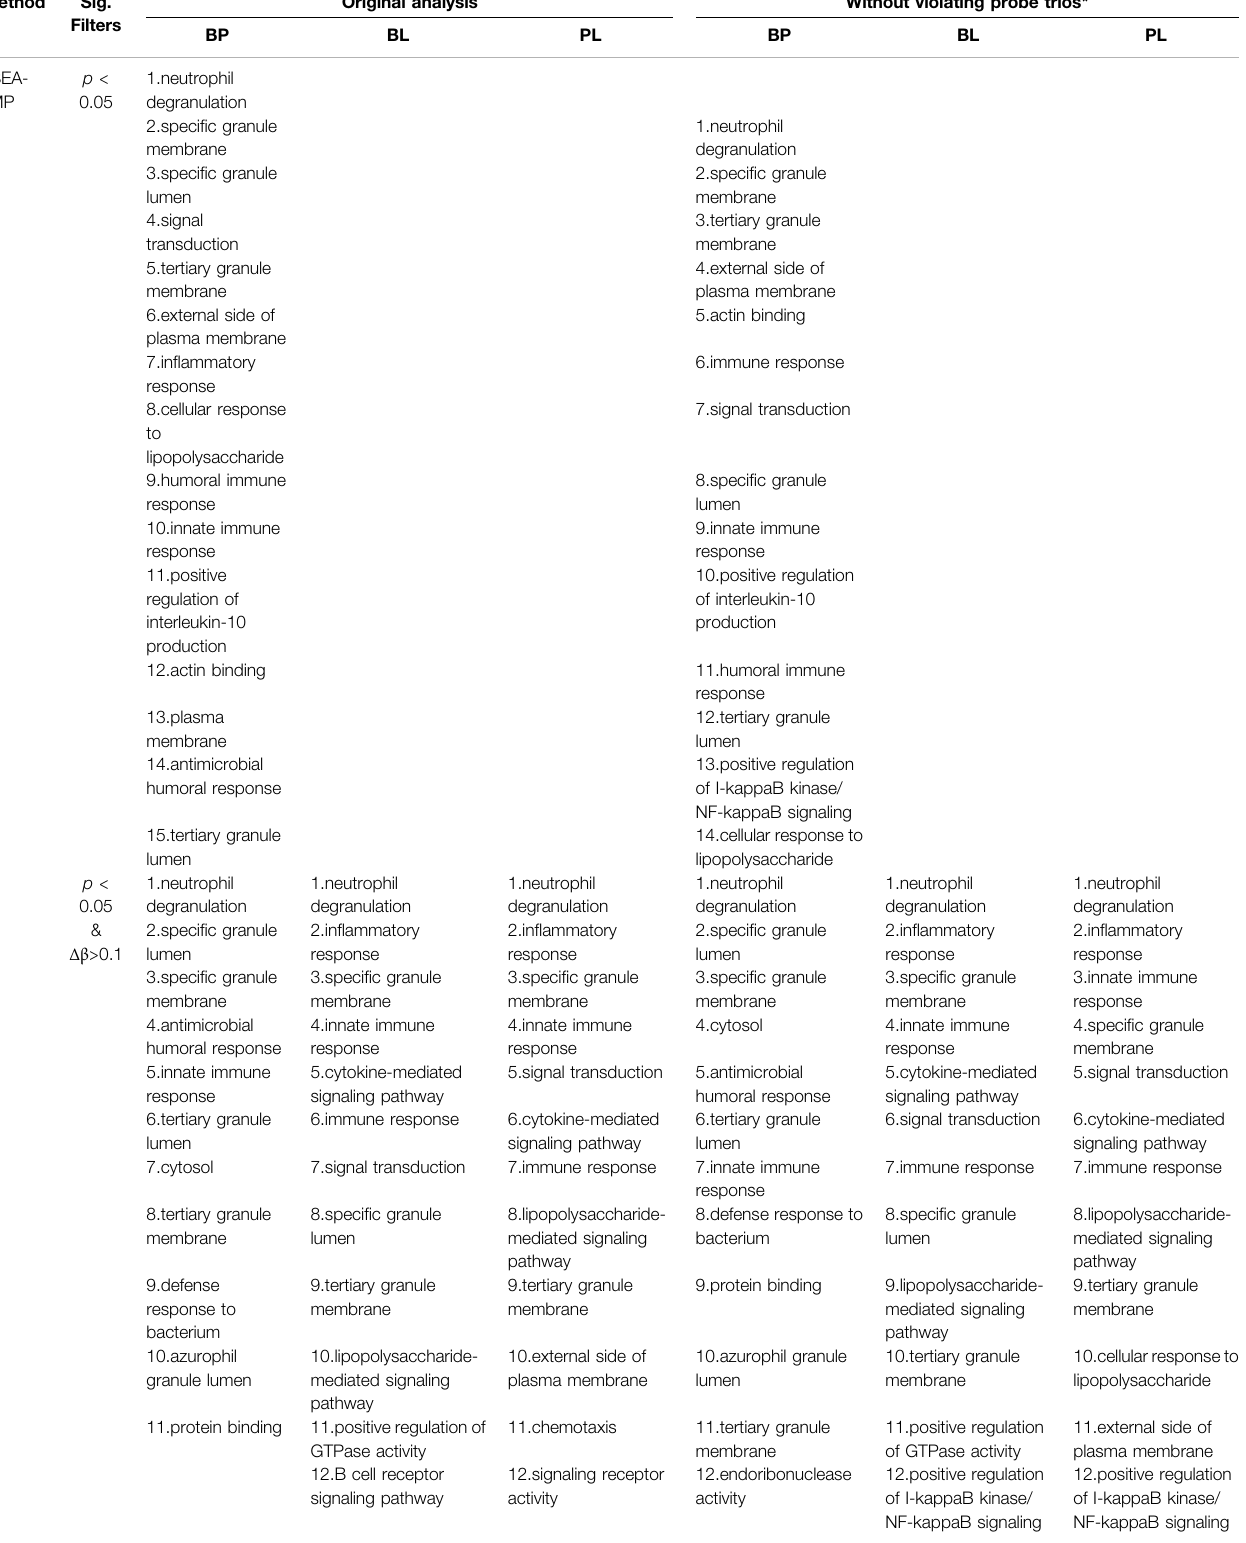
TABLE 3 | Gene sets